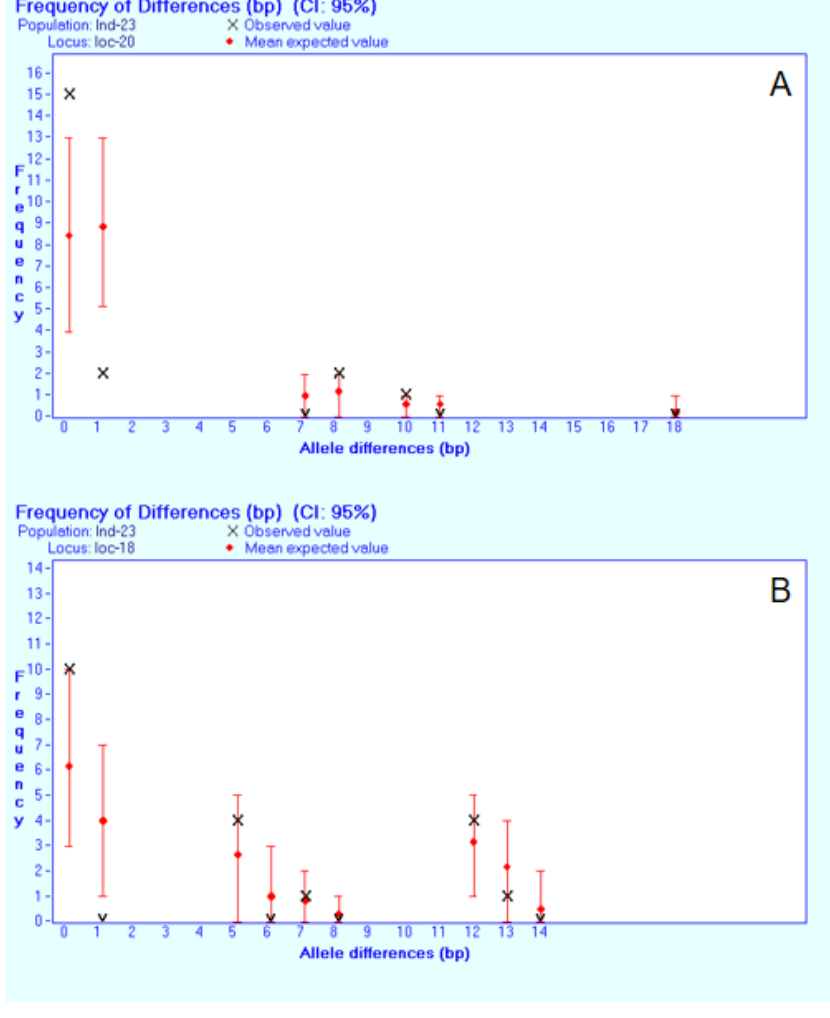
Figure 1: Examples of significant stuttering tests using MicroChecker graphic outputs. Black crosses represent the number of observed genotype of a given class and red diamonds stand for the corresponding values expected under the null hypothesis (random mating). The abscissa are the different genotypic classes in terms of size differences between the two alleles within an individual (e.g. 0 stands for homozygous genotypes). 1-A: an example with a significant homozygous excess and a significant deficit of heterozygotes with one repeat size difference between the two alleles. 1-B: an example where only the deficit of heterozygotes with one repeat size difference between the two alleles was significant. In the present paper, both situations are considered significant while only the first one is for